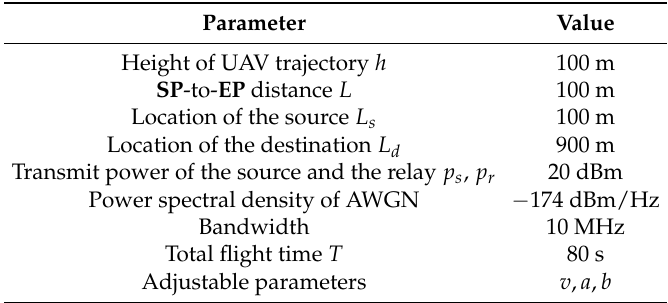
Table 1. Values of the System Setting Parameters for